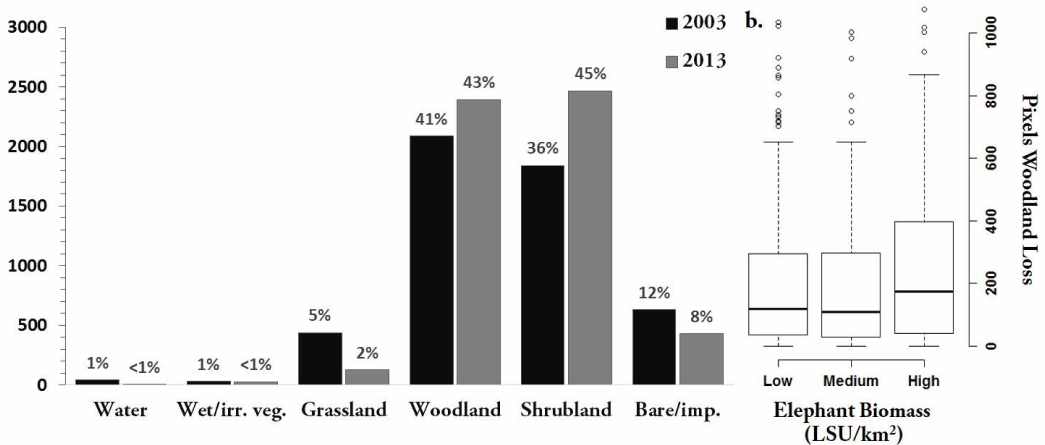
Figure 12. ( a ) Area (km 2 ) and percent land cover in 2003 and 2013 aerial survey units with elephants ( b ) boxplots of elephant biomass (LSU/km 2 ) in aerial survey blocks from 2003, 2006, and 2012 grouped into low (<10), medium (10.1–20), and high (>20) classes vs. woodland loss from